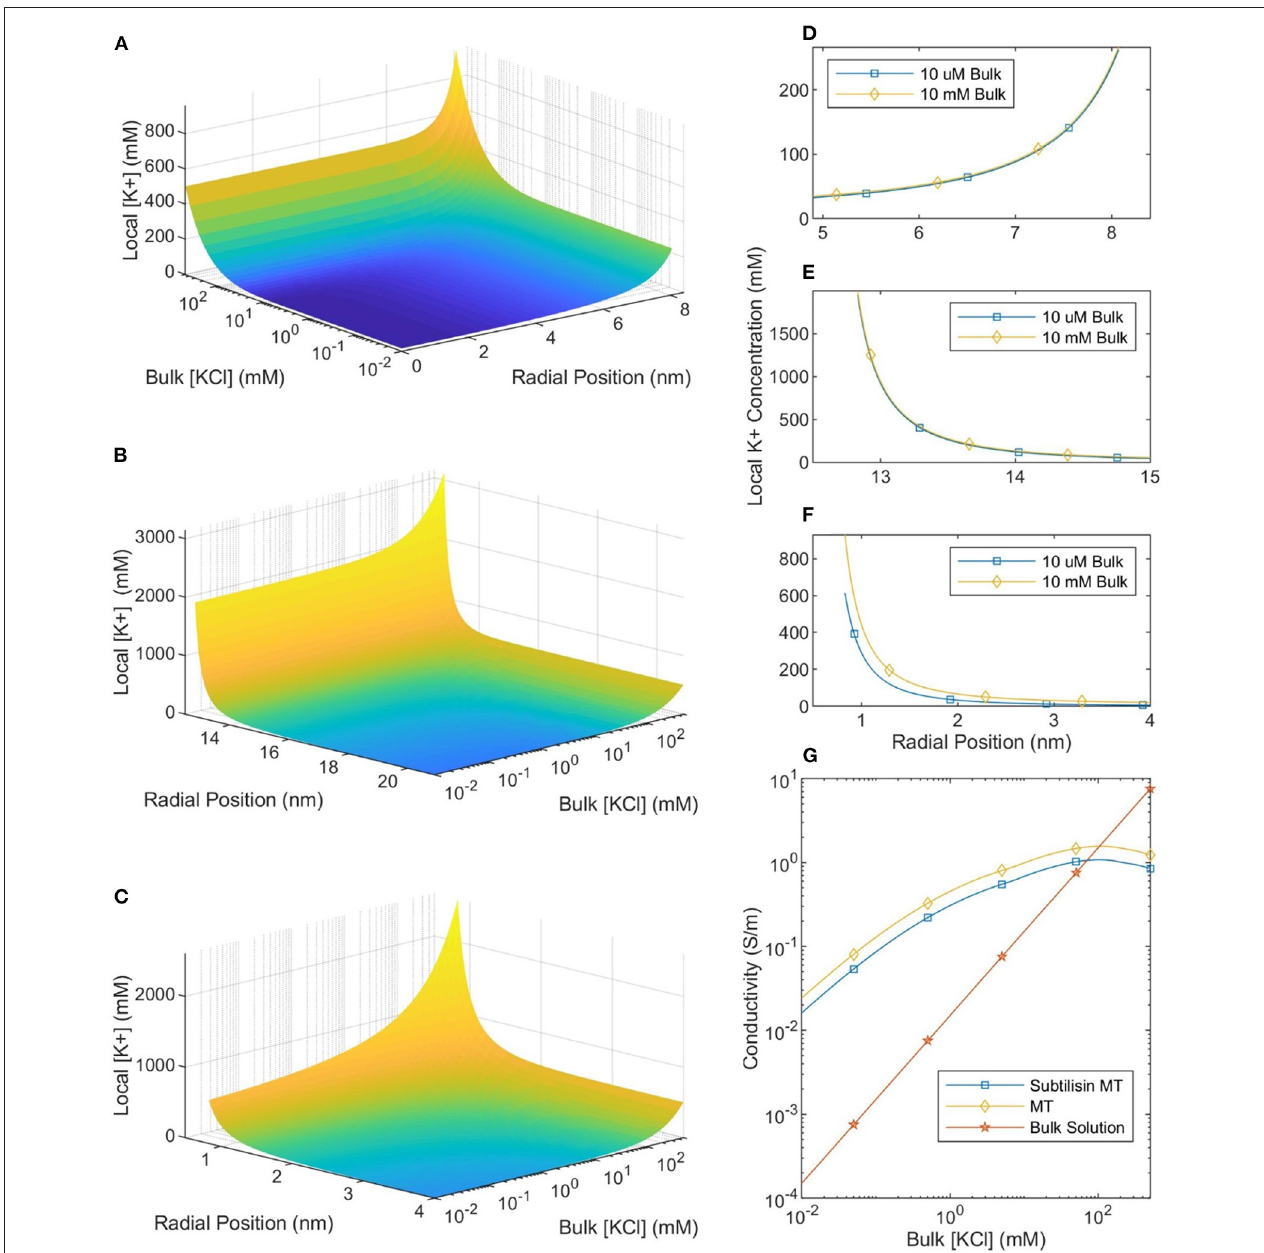
FIGURE 4 | The local counterionic concentration—as a function of buffer ionic concentration—in the lumen (A) , around the outer SMT surface (B) , and around a CT (C) . The radial position in (A,B) is measured from the center of the SMT while the radial position in (C) is measured from the center of the CT. (D–F) Show the similarity of the counterionic concentration profiles—near the lumen, outer SMT surface, and CT surface, respectively—for MTs in 10 µ M and 10 mM ionic buffer solutions. (G) Shows the conductivity of the bulk solution, an SMT-ion complex, and an MT-ion complex as a function of bulk solution ionic